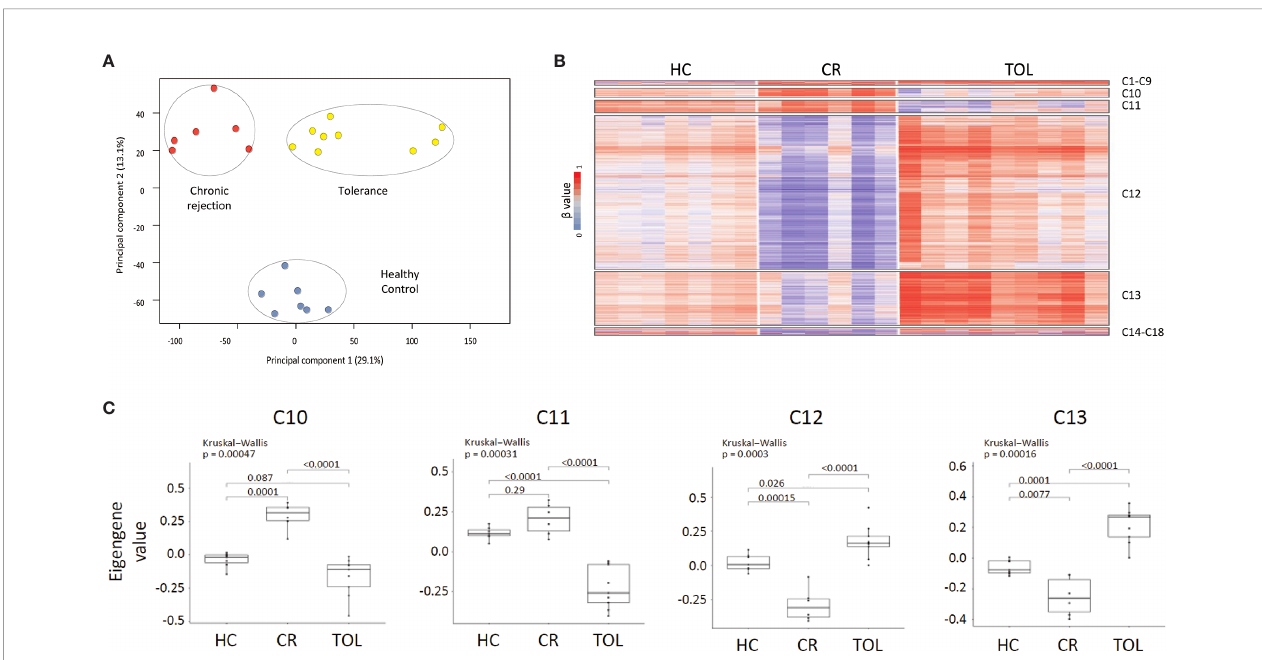
FIGURE 1 | DNA methylation dynamics associated with transplant outcome. (A) PCA analysis of DNA methylation data from healthy controls (HC), chronic rejection (CR) and operational tolerance (TOL) kidney-transplanted recipients. (B) Weighted gene co-methylation network analysis in kidney transplant recipients. The analysis included all differentially methylated regions between HC, CR and TOL patients ( b > 0.2, FDR <0.05). (C) Box plot of eigengene values in each gene cluster. These values are those of the fi rst principal component of the DNA methylation data in each module. The signi fi cance of group differences was determined by the Kruskal- Wallis test, followed by a post-hoc